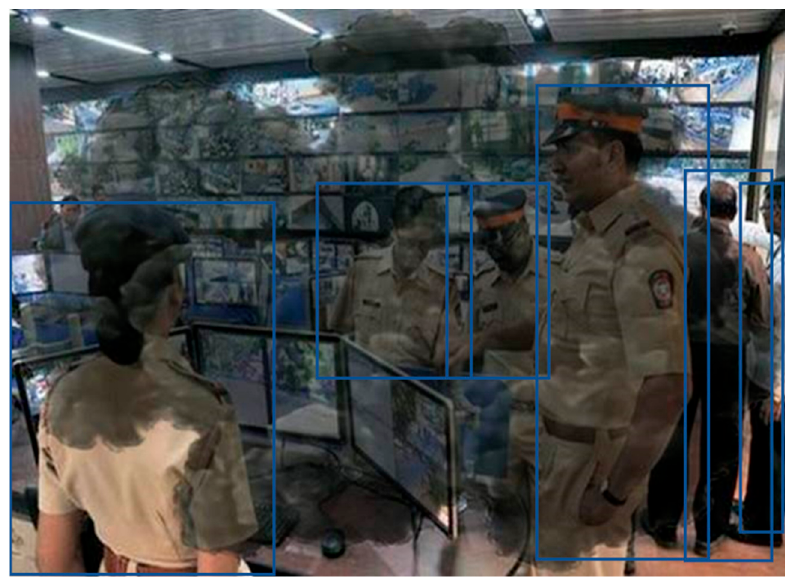
Figure 8. Image showing results of human detection using YOLOv3.